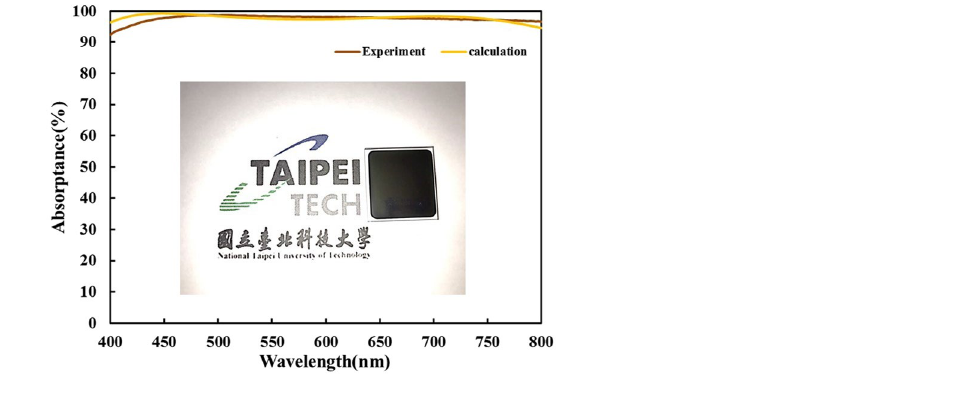
Figure 11. Measured and calculated absorptance spectra of Air/Ta 2 O 5 (40 nm)/Ge(20 nm)/Cr(15 nm)/ Al(30 nm)/Cr(15 nm)/Ge(20 nm)/Ta 2 O 5 (40 nm)/glass at normal incidence. Inset shows a photograph of the fabricated absorber